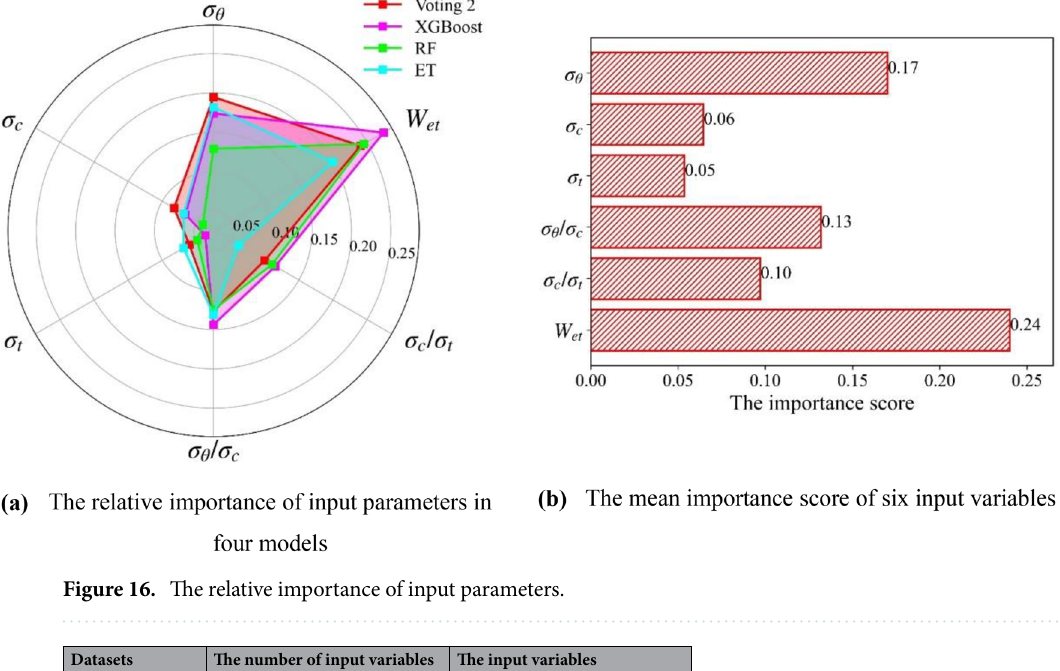
Figure 16. The relative importance of input parameters.